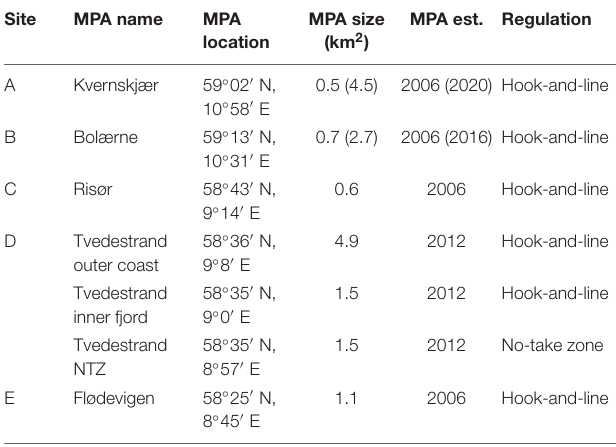
TABLE 1 | Name and location of MPAs used as study sites in the reviewed literature listed from East to West in